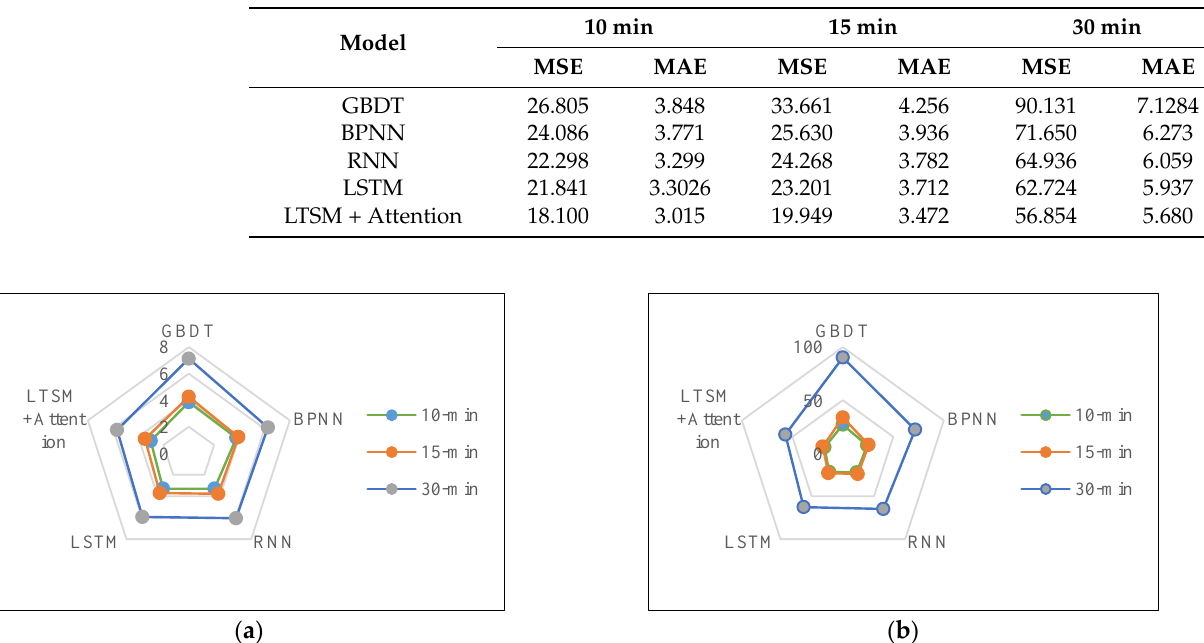
Figure 9. Comparison of prediction errors of different models. ( a ) MAE comparison of different models. ( b ) MSE comparison of different models.